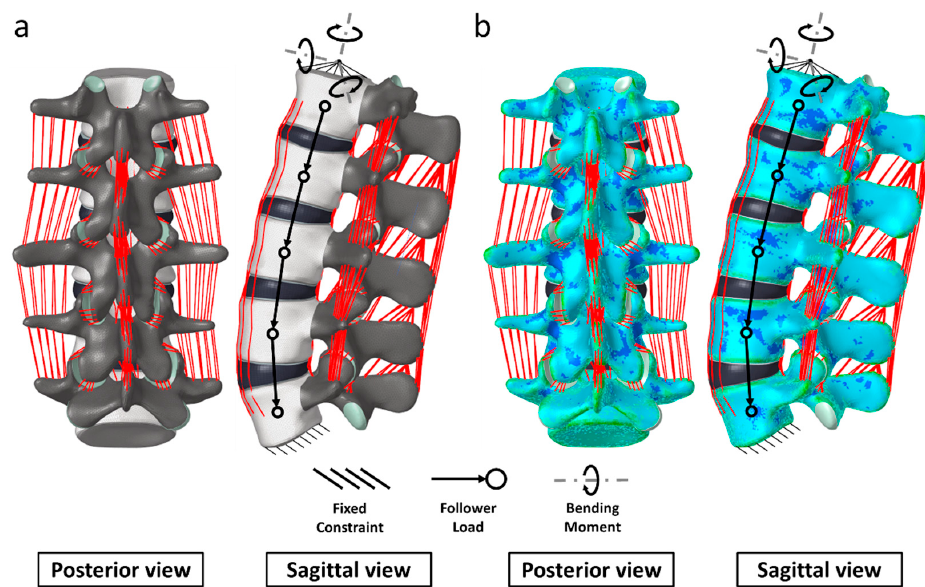
Figure 2. Finite element models of the lumbar spine with loads and constraints: ( a ) the literature- based model and ( b ) the patient-specific model.